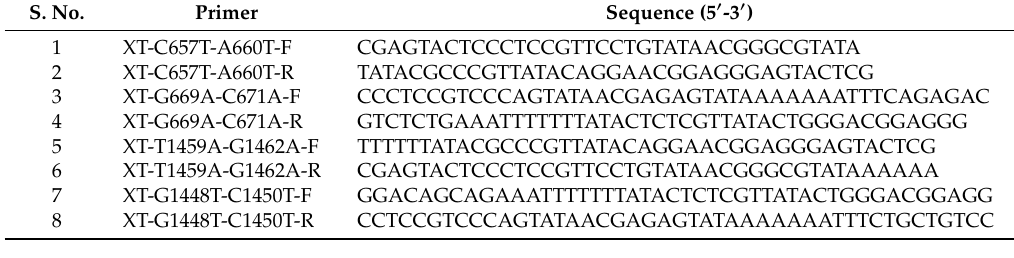
Table 3. The primers and their sequences used for site-directed mutagenesis of Ppmar2NA -TIRs. S. No.